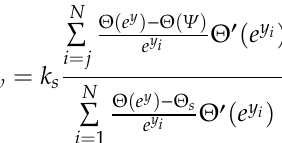
( b ) Figure 3. SWCC curves. ( a ) Permeability coefficient function. ( b ) Volume water content function. 3.3. Definition of Anisotropy and Calculation Conditions Previous studies mostly ignored the anisotropy ratio and direction. In fact, anisotropy widely exists in the soil. For the hydraulic conductivity matrix [C] in Equation (2), it can be expressed as     =